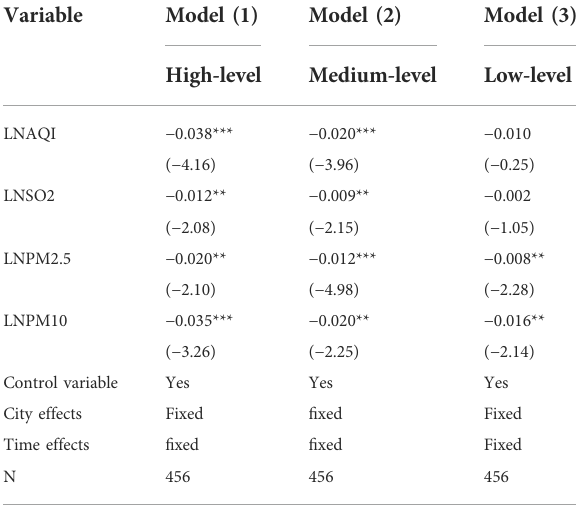
TABLE 5 Impact heterogeneity test under different levels of digital economy